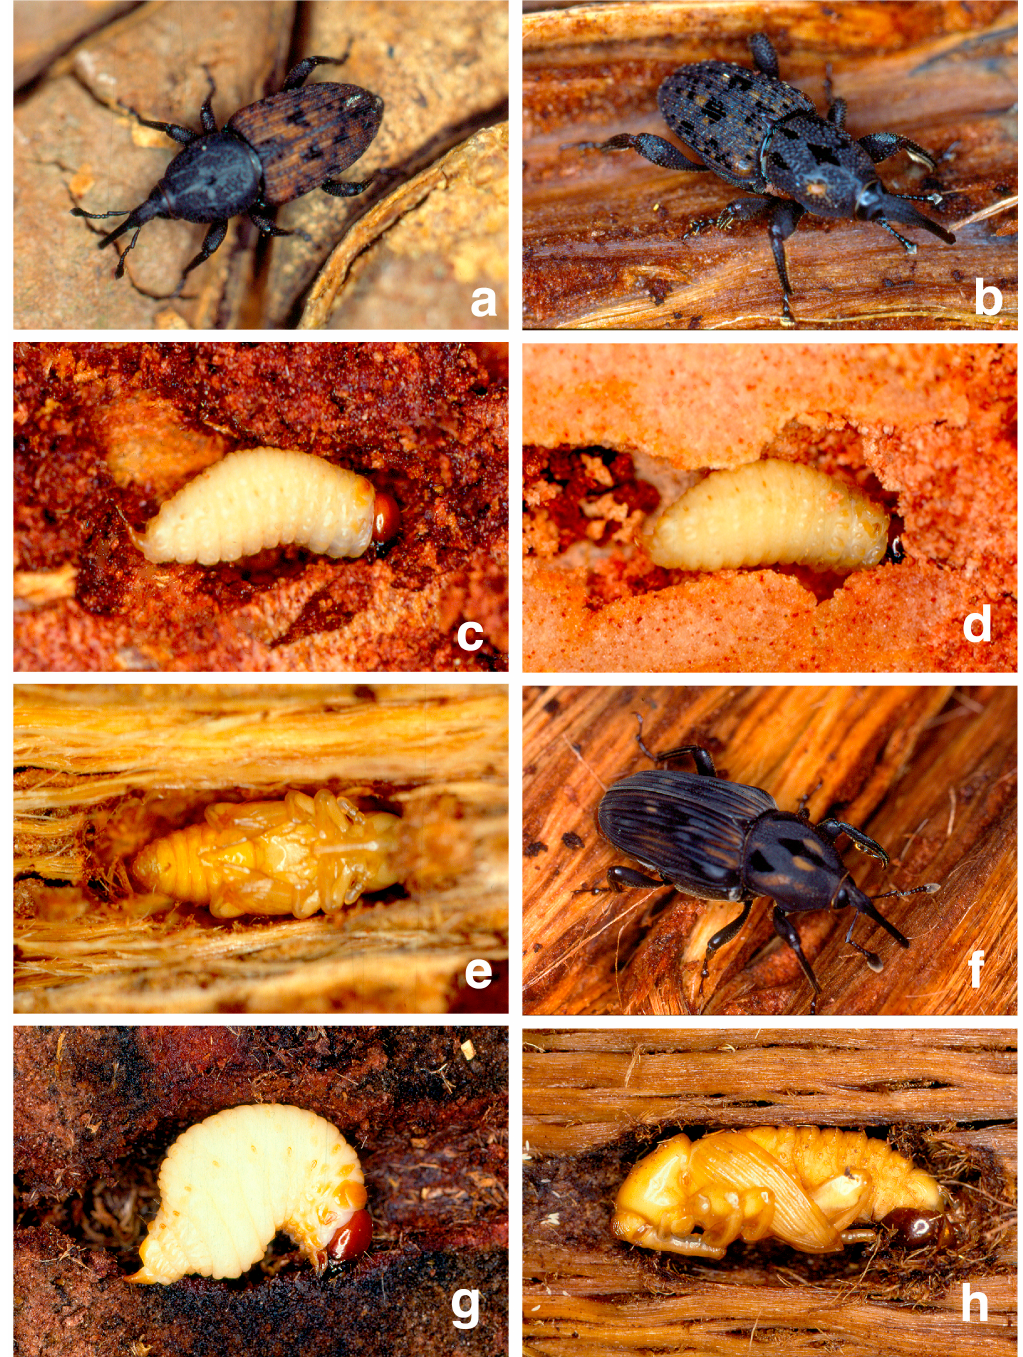
Figure 93. Phacecorynes variegatus : ( a ) adult; ( b ) variable form, adult; ( c ) larva, lateral view; ( d ) larva, lateral view partially concealled; ( e ) pupa, ventral view; Phacecorynes sommeri : ( f ) adult; ( g ) larva, lateral view; and ( h ) pupa, lateral view. Photographs courtesy of Rolf Oberprieler.